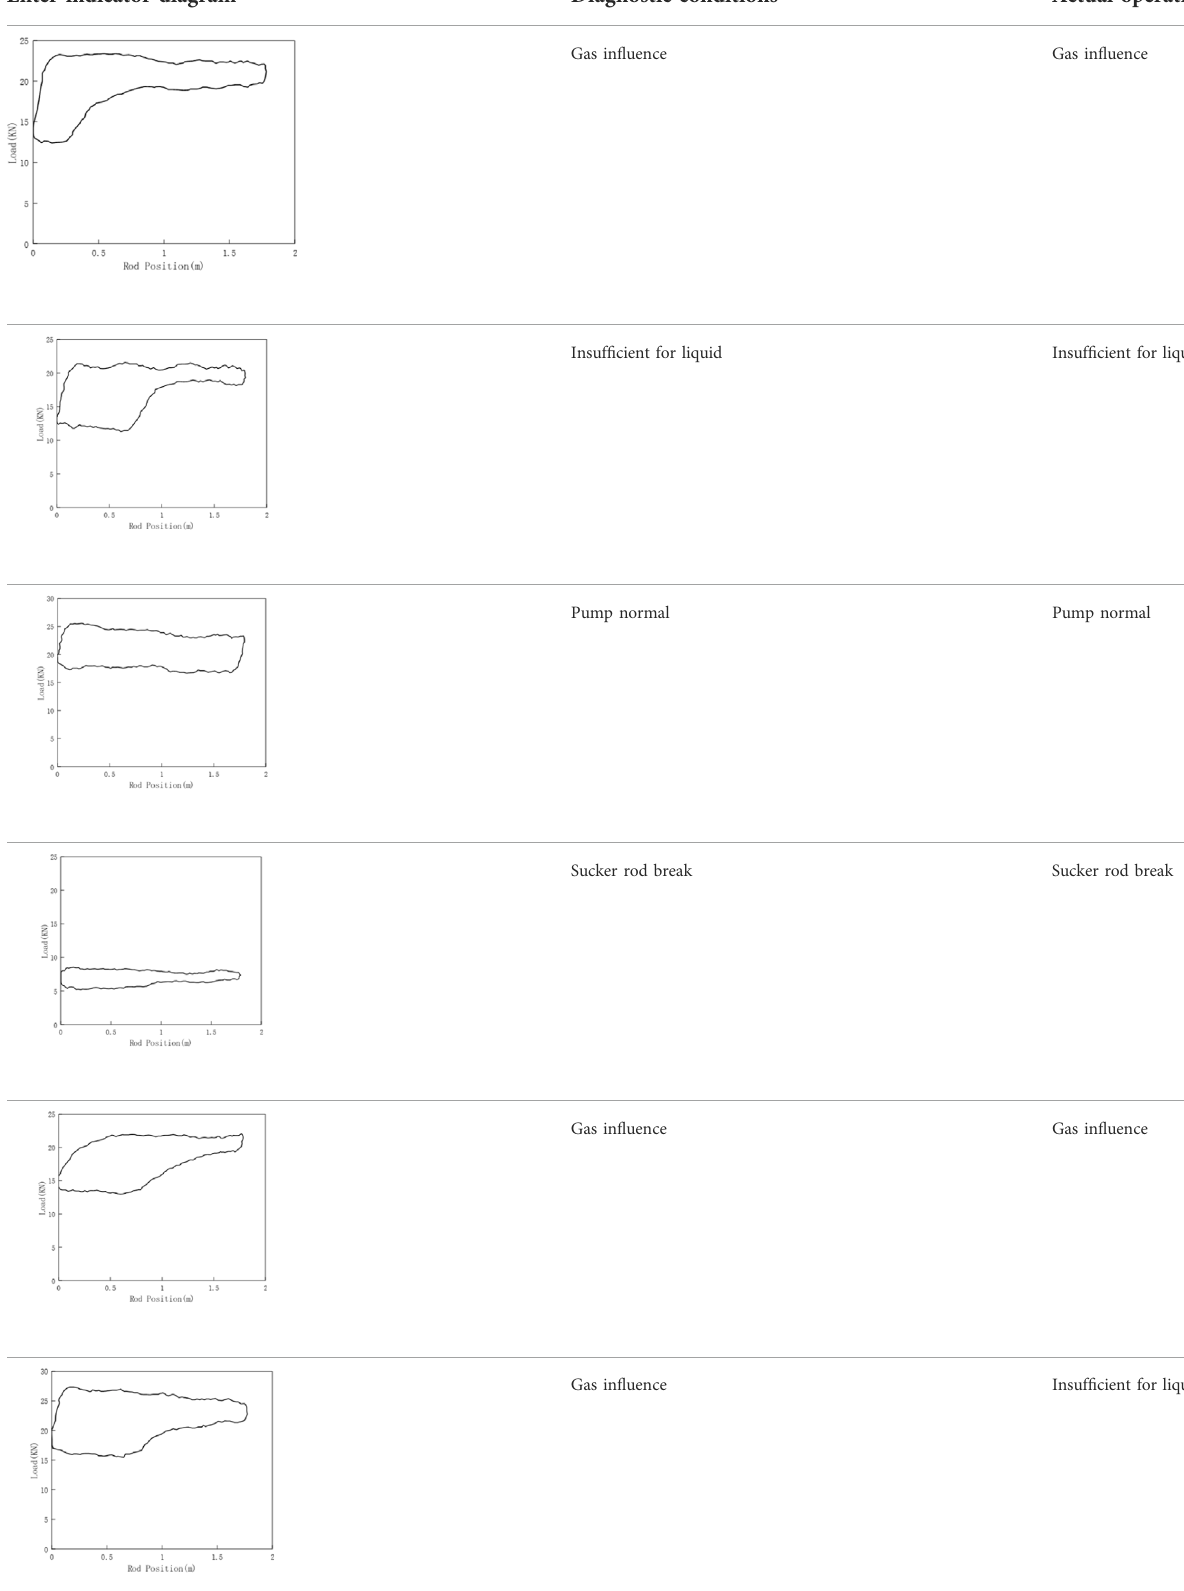
TABLE 6 Diagnostic results of indicator